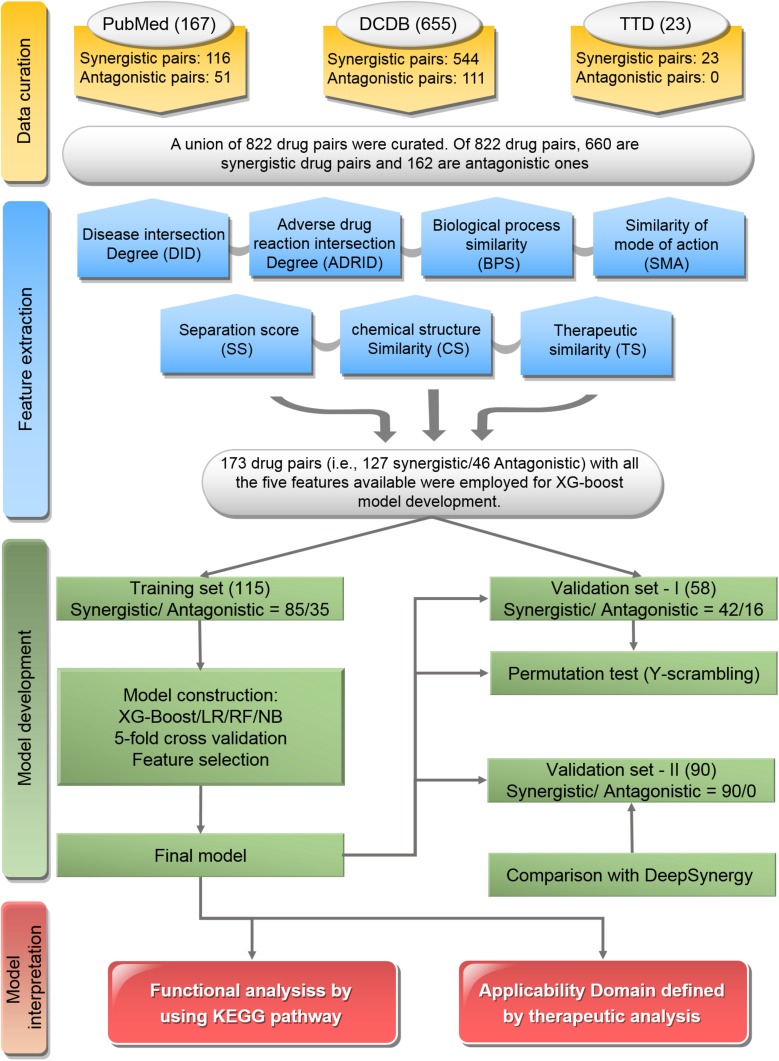
Flowchart of the study: The workflow includes data curation, feature extraction, model development, and model interpretation.